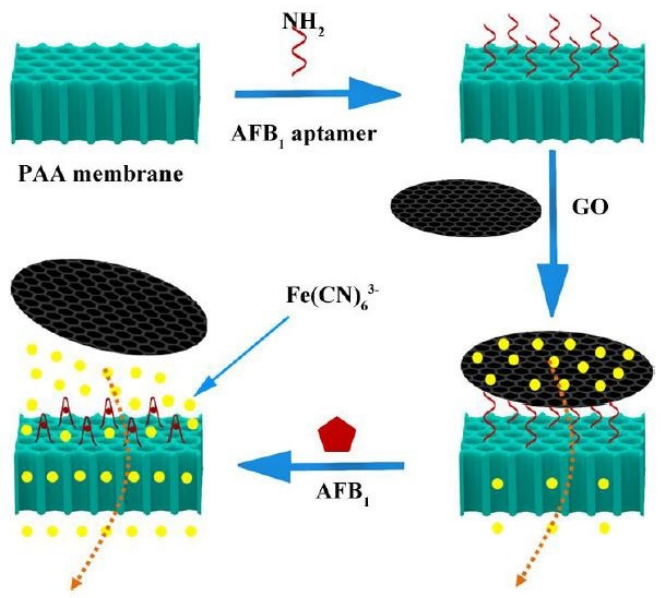
Figure 6. Illustration of the working mechanism of the GO-modified PPA membranes for the detection of AFB1 molecules [119]. Reproduced from Mo, R., He, L., Yan, X., Su, T., Zhou, C., Wang, Z., Hong, P., Sun, S. and Li, C., 2018. A novel aflatoxin B1 biosensor based on a porous anodized alumina membrane modified with graphene oxide and an aflatoxin B1 aptamer. Electrochemistry Communications , 95 , pp. 9–13.